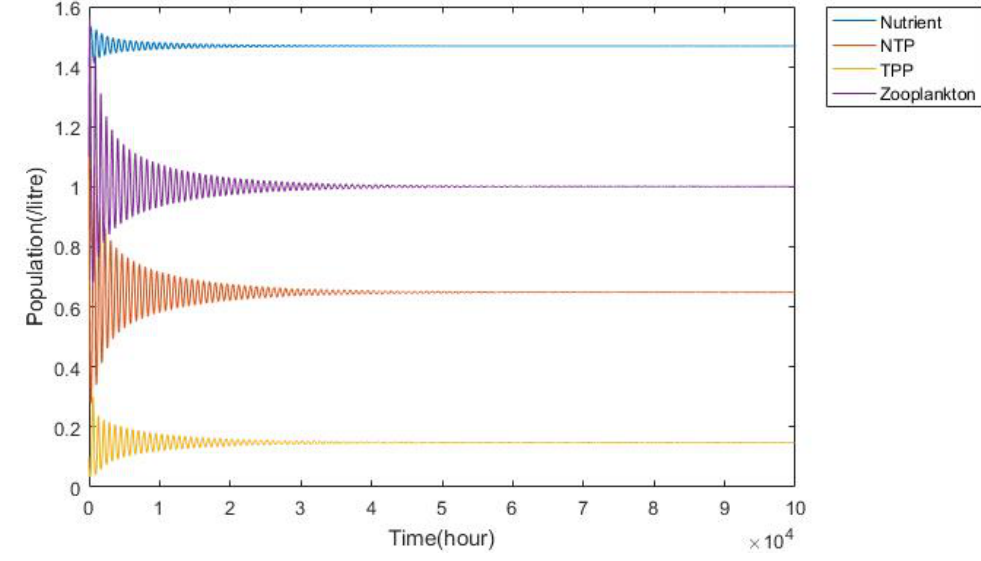
Figure 4. Simulation results of System (2) with τ = τ 0 = 22.6841.